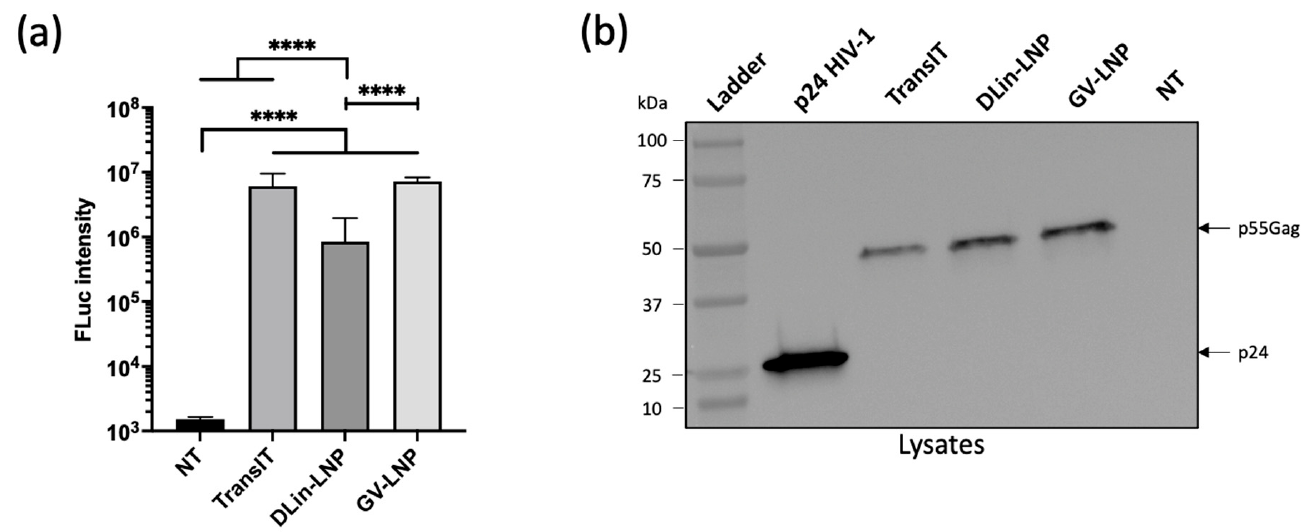
Figure 1. LNP-Fluc or p55Gag mRNAs purified at 20 ◦ C show efficient in vitro transfection and mRNA translation. ( a ) Untreated HeLa cells (NT), as well as Fluc mRNA (TransIT) and Fluc mRNA/LNP nanocomplexes (DLin-LNPs and GV-LNPs), were transfected in complete medium (100 ng/well). The luciferase activity was measured 24 h post transfection. ( b ) p24 recombinant protein and total cellular proteins (20 µ g per well) from HeLa cells transfected with TransIT ® or LNP-p55Gag mRNA complexes were separated onto a gradient SDS/PAGE gel (4–15%) and analyzed by Western blot using an anti-p24 monoclonal antibody specific of the HIV Gag protein. Luciferase intensity data are presented as the mean ± SD; two-way ANOVA statistical analysis was applied, followed by a Dunnett’s multiple comparison test; **** p < 0.0001.